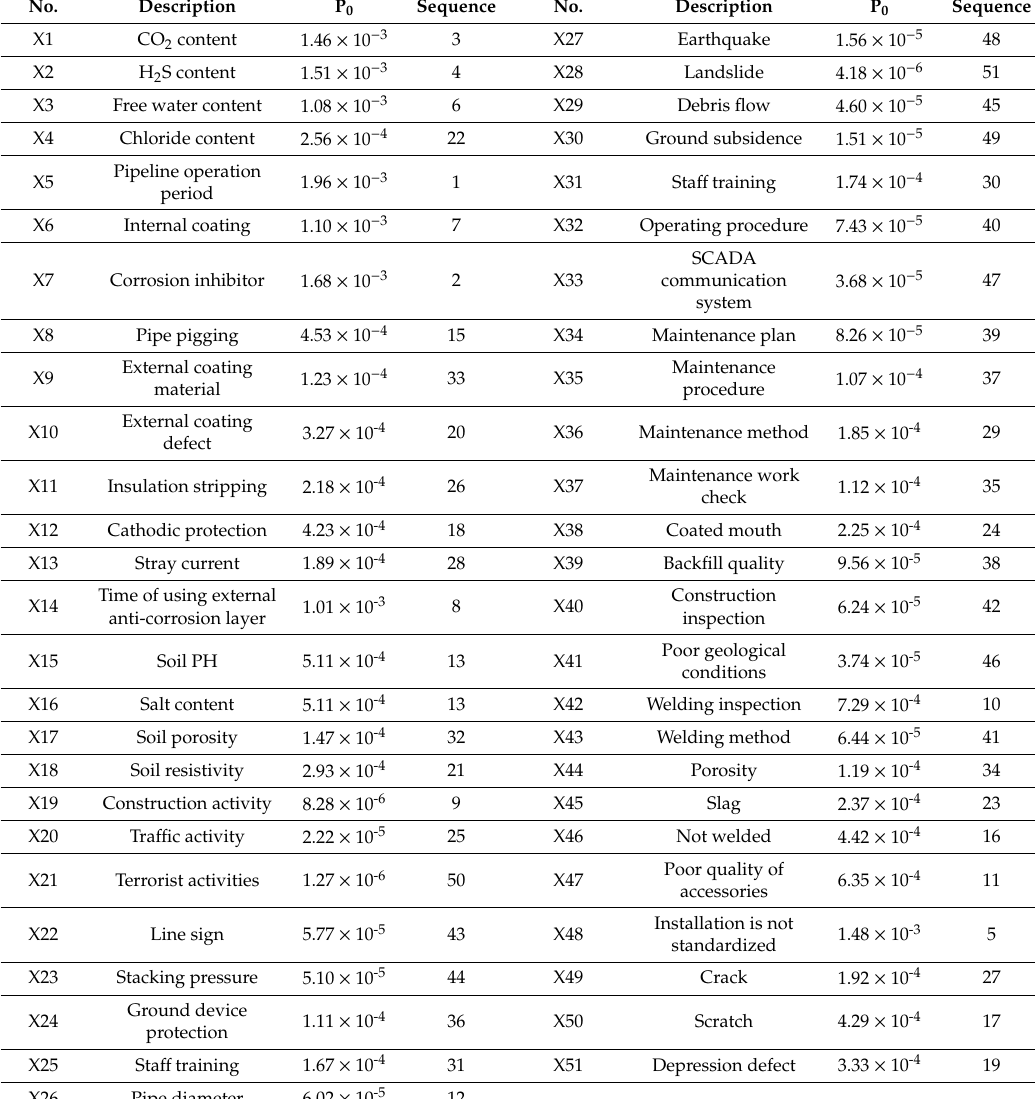
Table 8. Prior failure probability of root